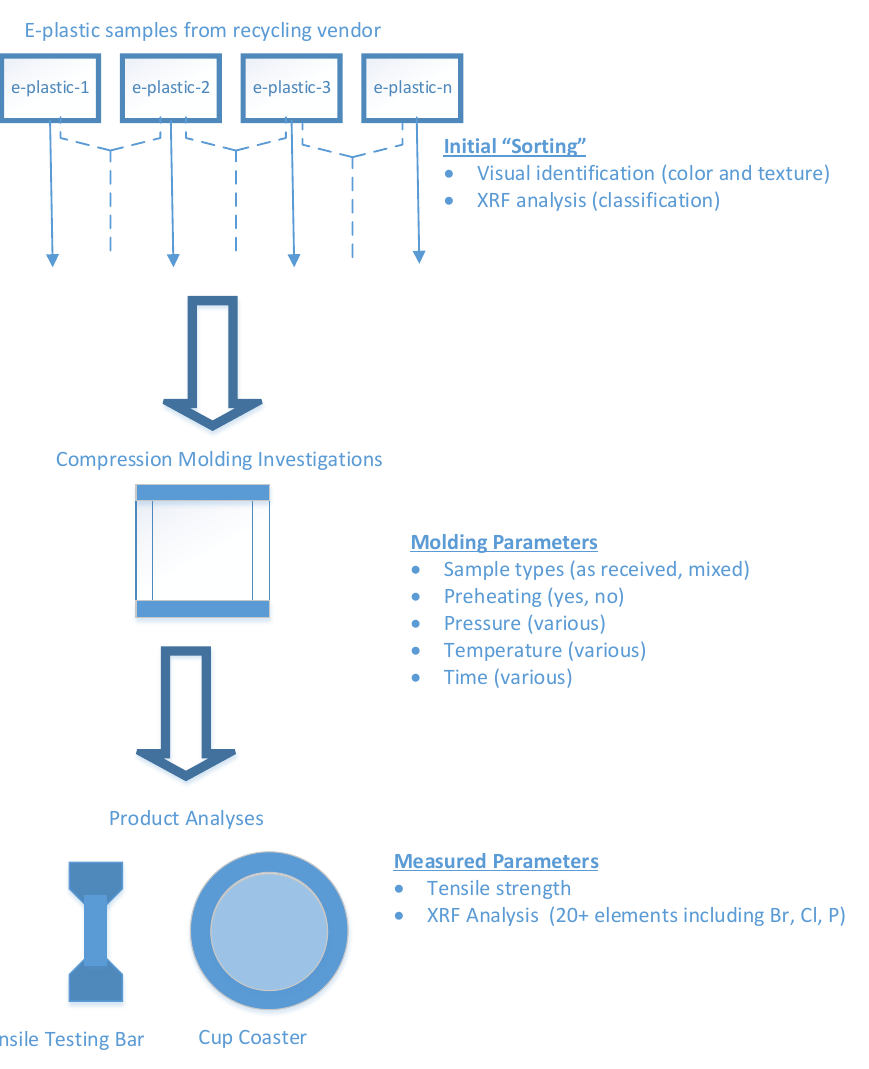
Figure 2. Schematic representation of work covered in this paper.